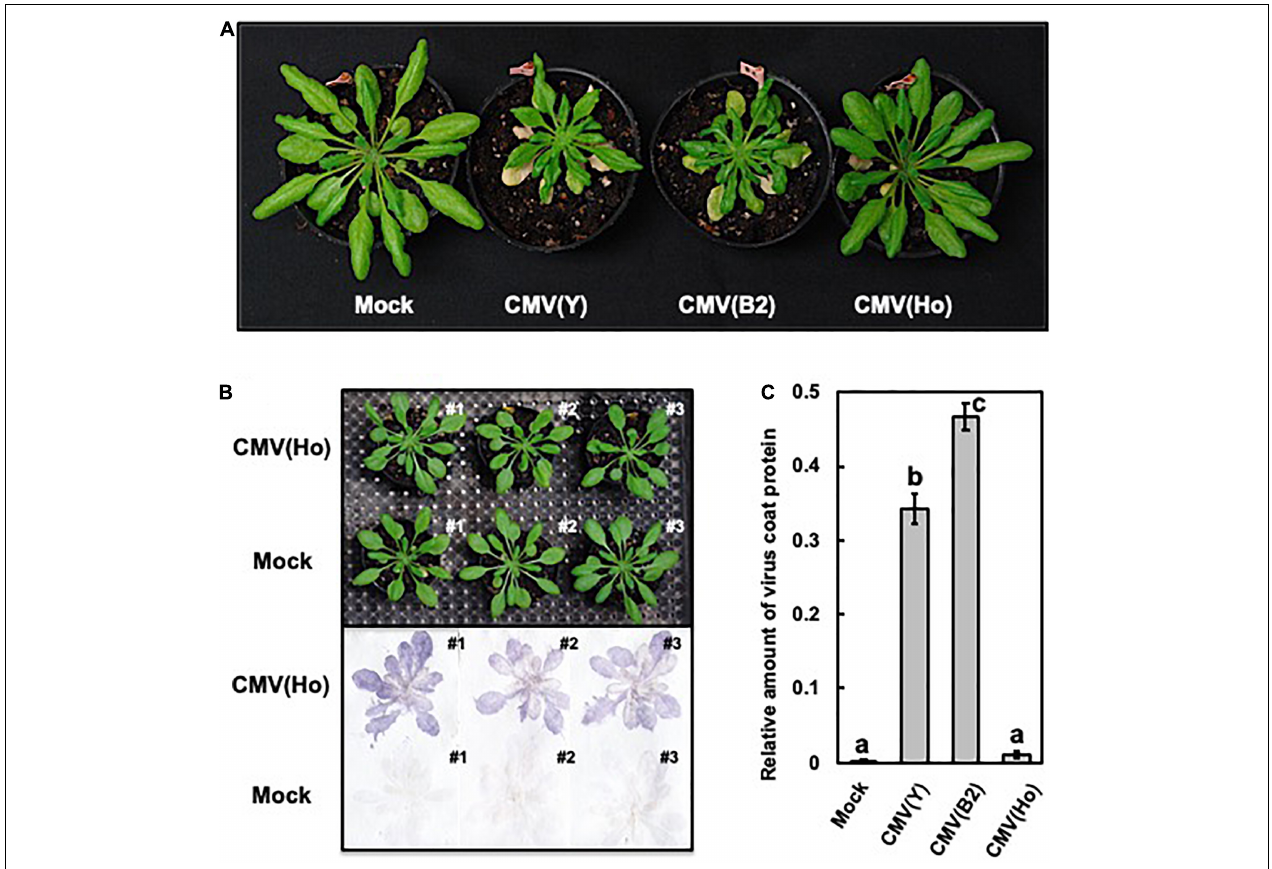
FIGURE 1 | Observation of systemic symptoms and accumulation of virus coat protein in cucumber mosaic virus (CMV)-infected A. thaliana ecotype Col-0. Photographs of Col-0 plants at 21 days post-infection (dpi) with CMV(Ho) and two virulent strains of CMV [CMV(Y) and CMV(B2)]. As a control, Col-0 plants were rub-inoculated with 50 mM sodium phosphate buffer (pH 7.0) (mock) (A) . Virus coat protein in CMV(Ho)- and mock-inoculated plants at 21 dpi was detected by a tissue-printing method (B) . The amounts of coat protein in the inoculated leaves of three independent CMV(Ho)-, CMV(Y)-, or CMV(B2)-infected Col-0 plants and mock-inoculated plants were quantified by an enzyme-linked immunosorbent assay (C) . The average of the relative amounts of virus coat protein in virus- or mock-inoculated leaves ( n = 3) is shown by a bar chart with error bars ( n = 3, SD). The different letters indicate statistically significant differences in the average of relative amounts of the coat protein (Tukey’s test, p <